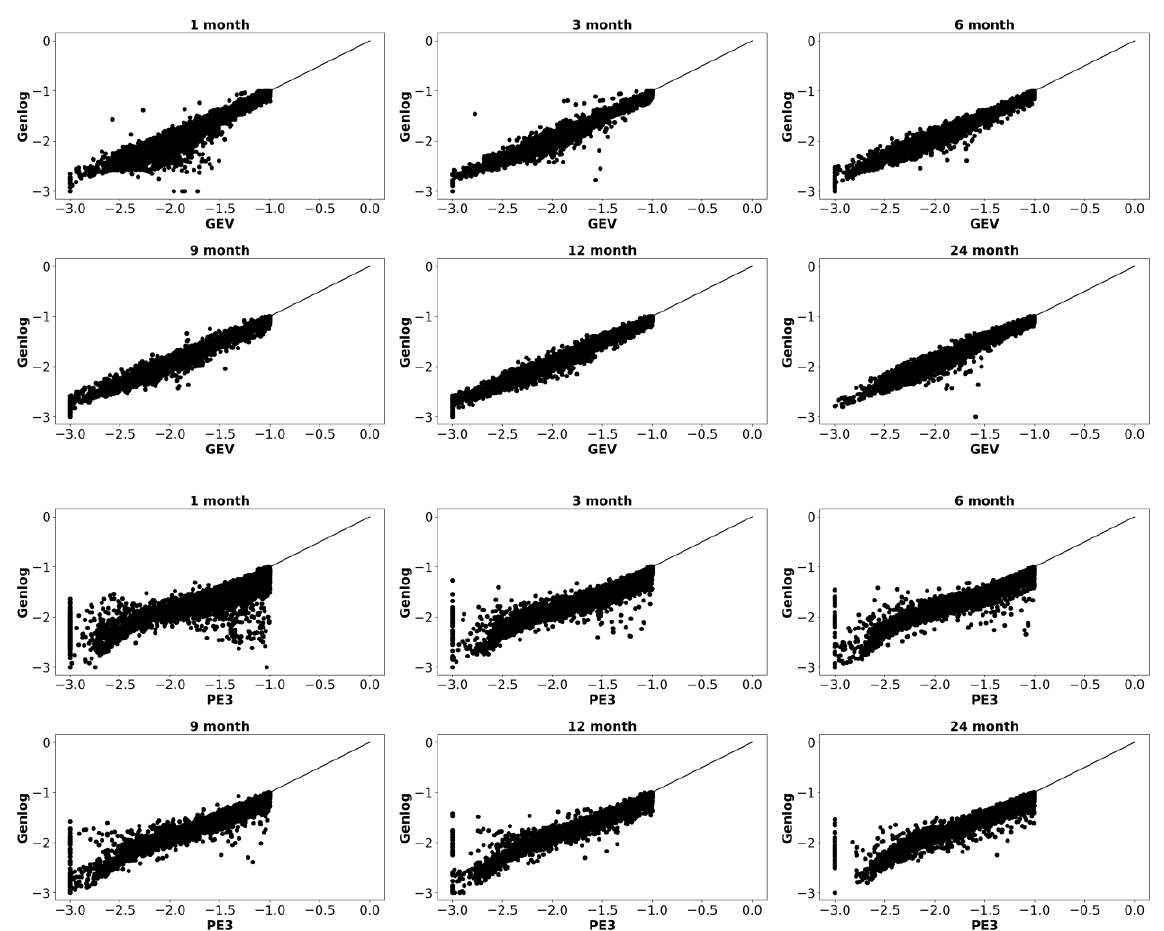
Figure 5. Scatter plot of the SPEI values estimated using all 125 gauging stations for all the accu- mulation periods whose values are less than − 1 where both the PE3 and the GEV distribution are compared relative to the Genlog distribution.